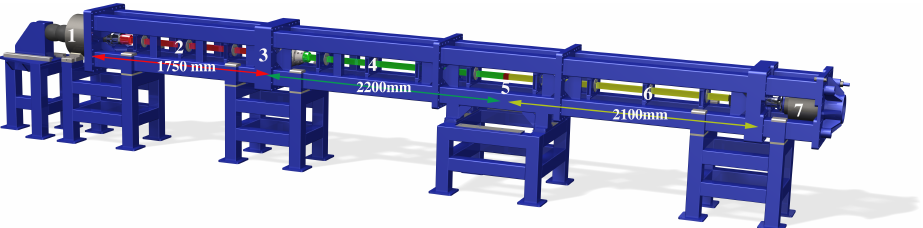
Figure 2. Experimental 3D-MHB